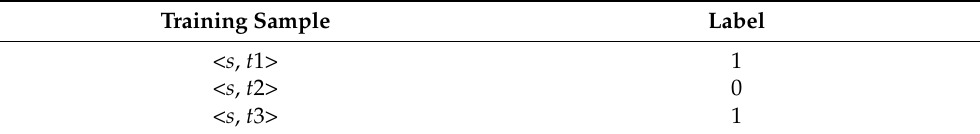
Table 2. Example of binary classification of